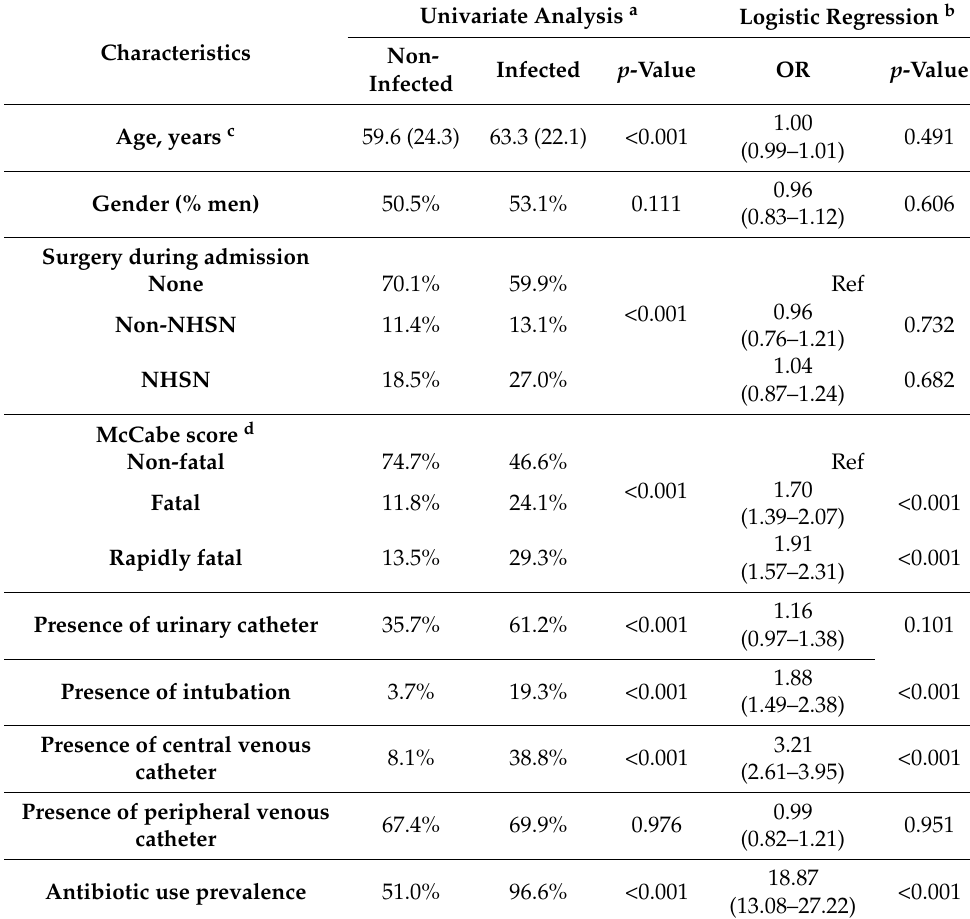
Table 2. Comparison of characteristics between infected and non-infected